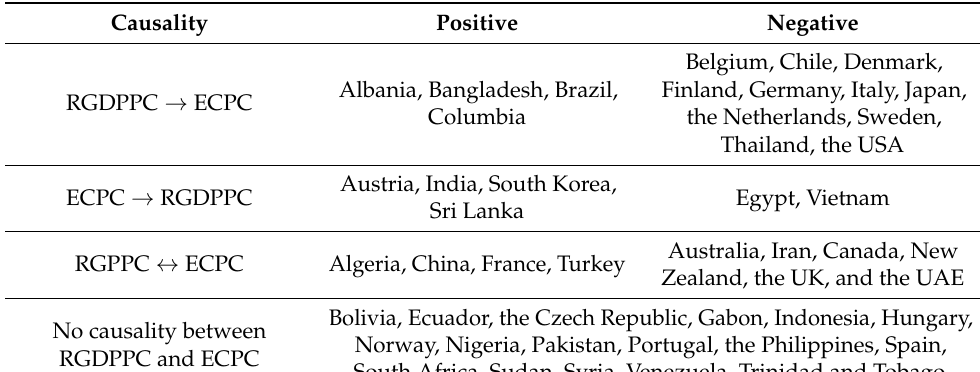
Table 3. Summary of long-run Granger causality